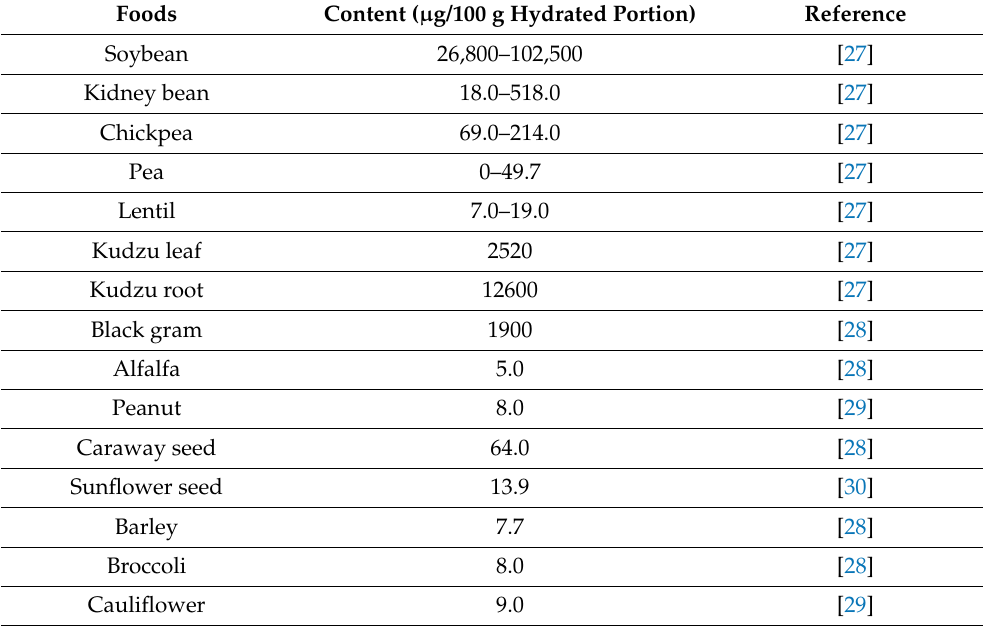
Table 1. The content of genistein in various